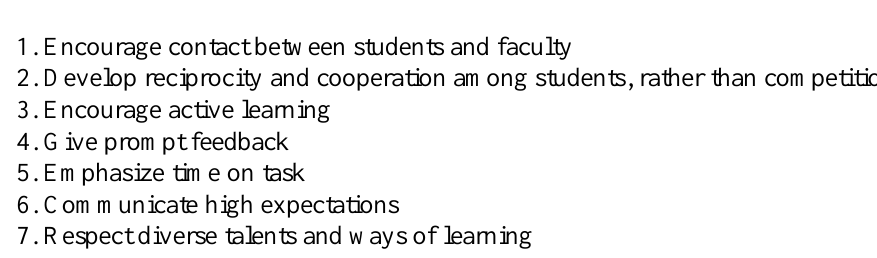
Table 1. Seven Principles of Good Practice in Undergraduate Education (Chickering & Gamson,